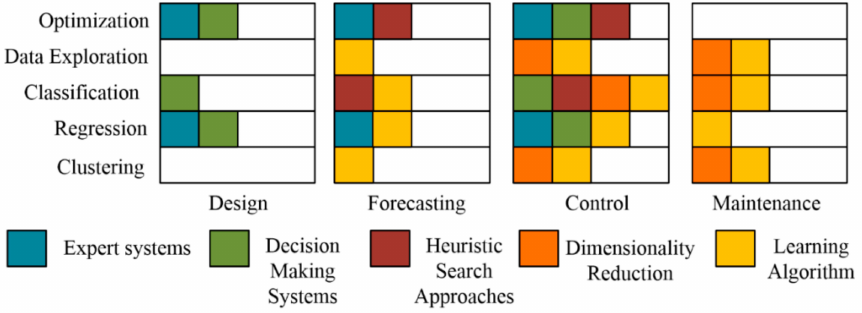
Figure 2. Generalization of different AI applications for the design, control, forecasting and mainte- nance of grid-tied PV